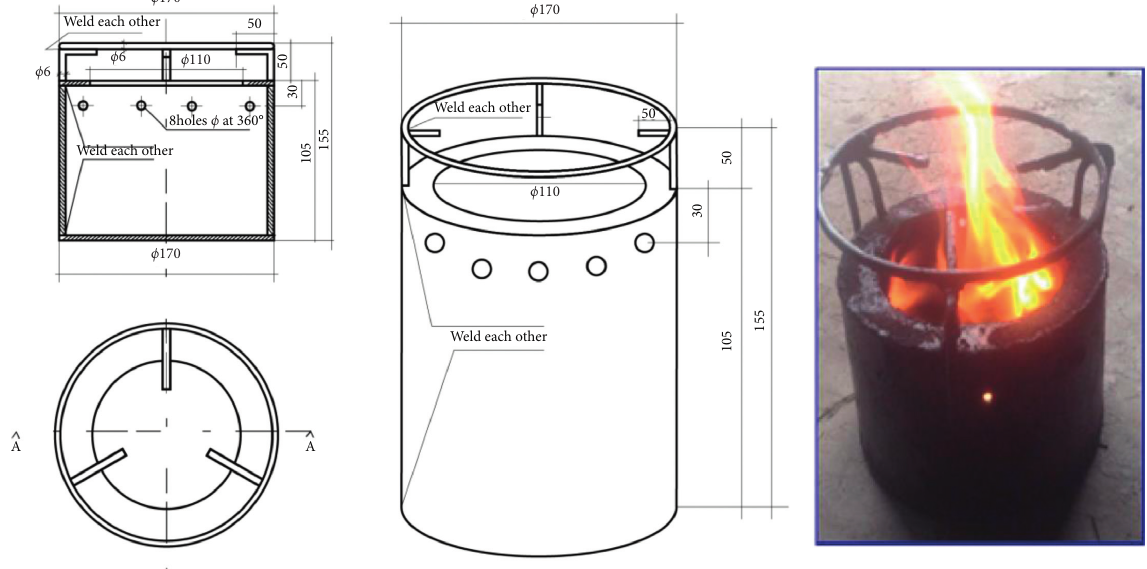
Figure 1: Design of the plant oil